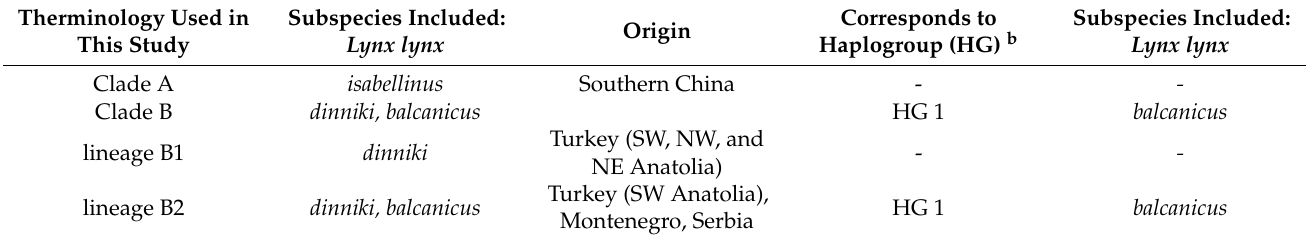
Table 3. MtDNA clades, lineages, and haplogroups of six Eurasian lynx subspecies a revealed in our study and what they correspond to in Lucena-Perez et al.